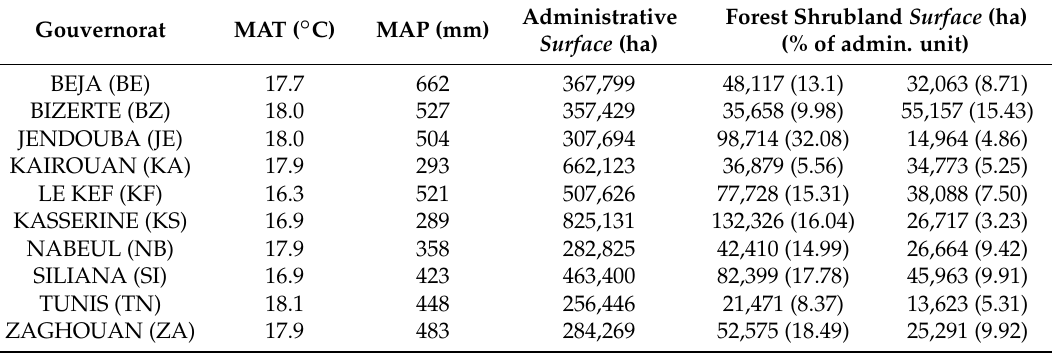
Table 1. Environmental description of the forested administrative units in Tunisia: Mean Annual Temperature (MAT) in ◦ C, Mean Annual Precipitation (MAP) in mm, surface area of the respective administrative units (in ha), and the forest and shrubland cover within these units (in ha). The percentage of forest and shrubland cover within each administrative unit is also indicated (% admin. unit in